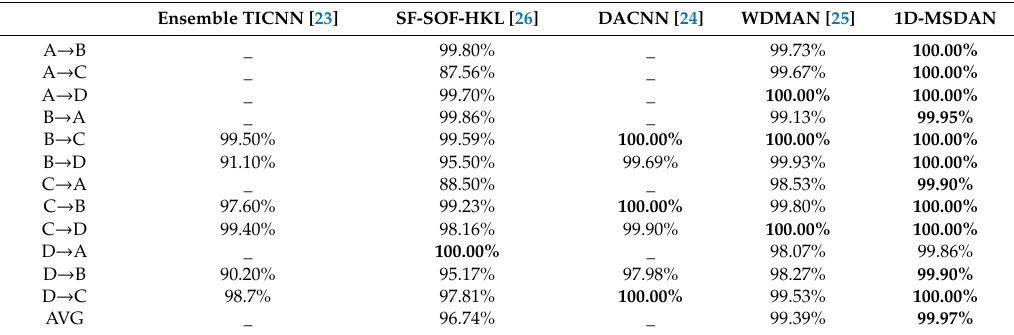
Table 3. Diagnostic accuracy (%) for 12